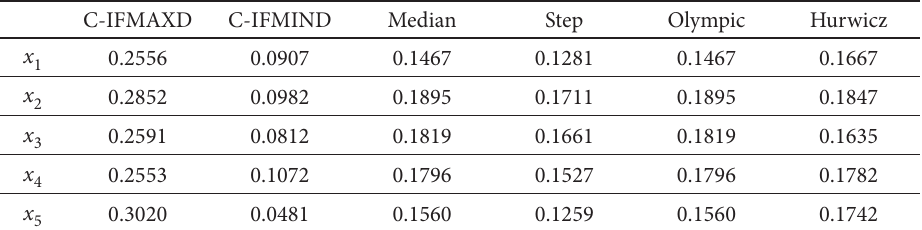
Table 11. Aggregation results 2